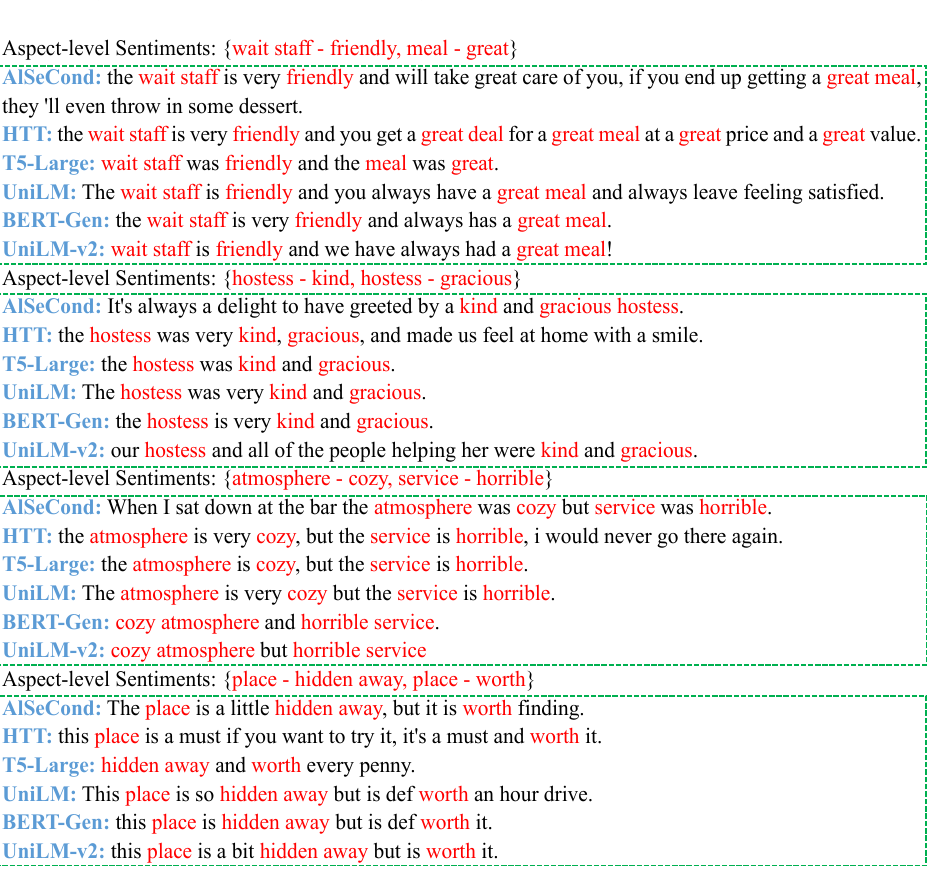
Figure 8. Generated samples from the generative models. Red phrases represent the aspect-level sentiment formed by aspect-opinion